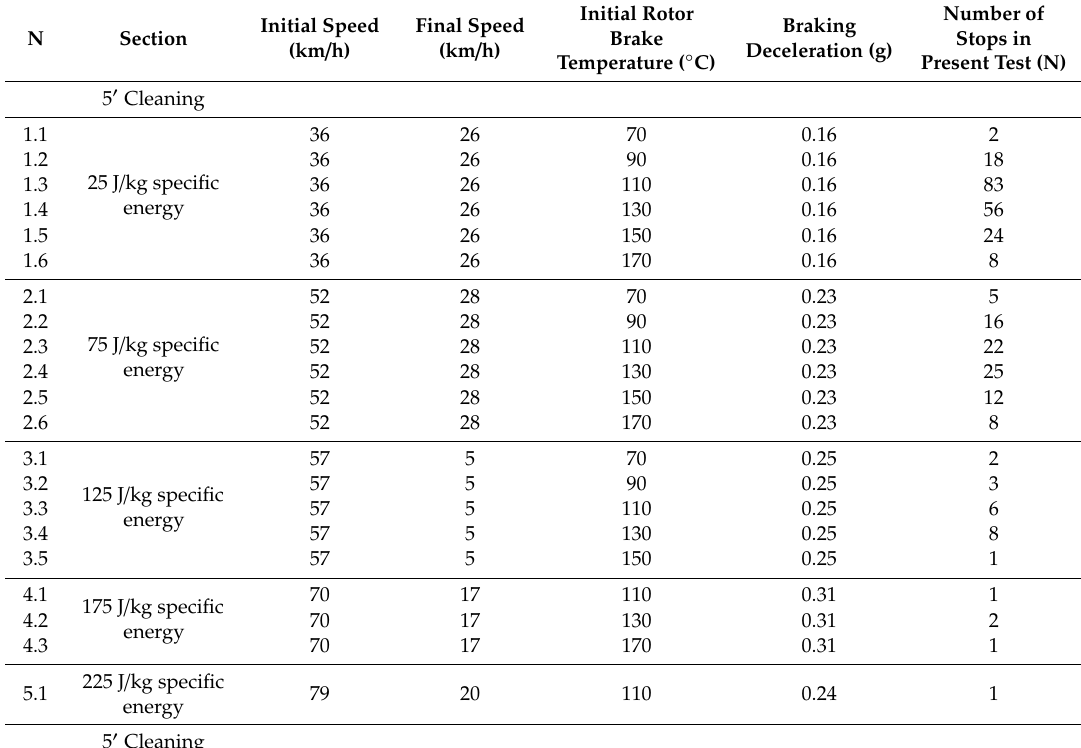
Table 3. Test driving cycle used in the dyno bench tests